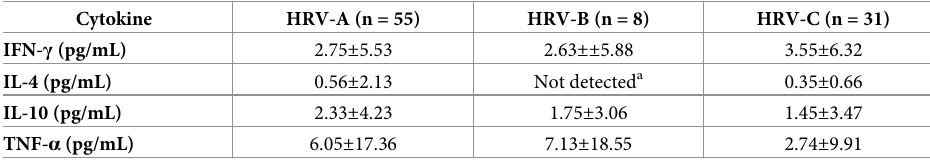
Table 3. Cytokine levels in nasopharyngeal aspirates by HRV